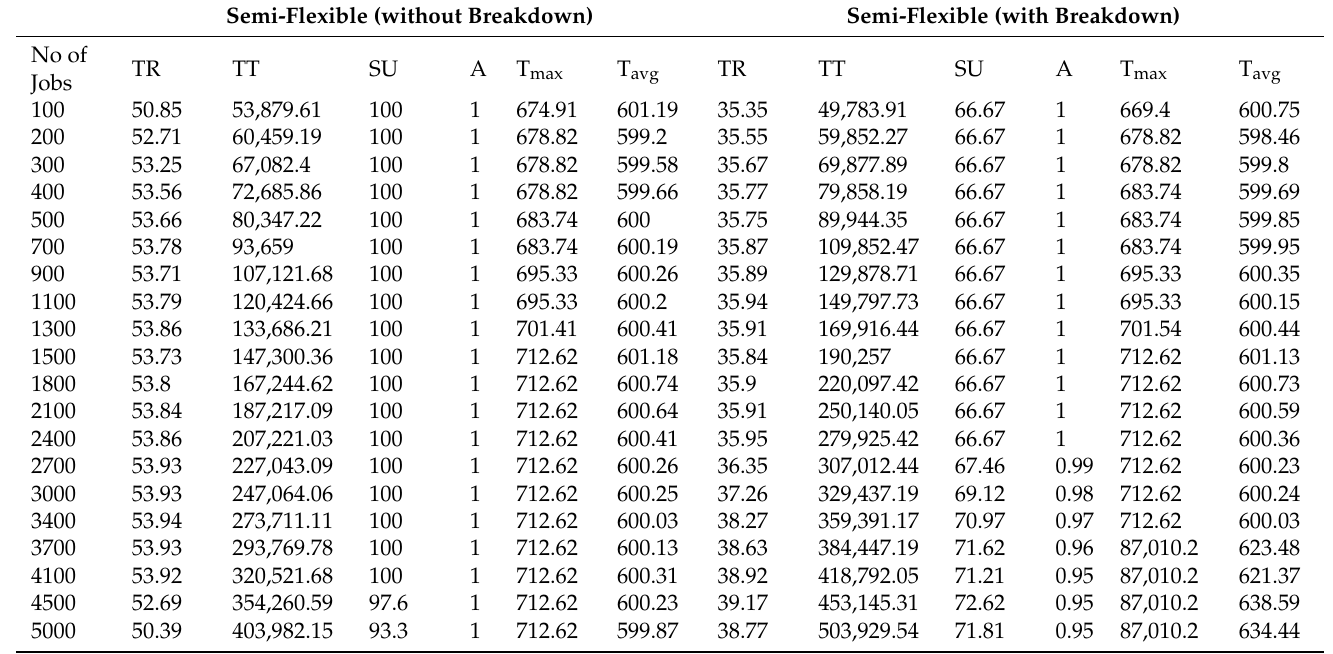
Table 5. Comparative Simulation Matrix of semi-flexible configuration by without and with break- down of machines.